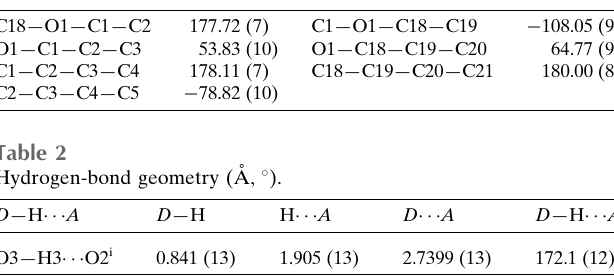
Table 1 Selected torsion angles ( (cid:3) ).